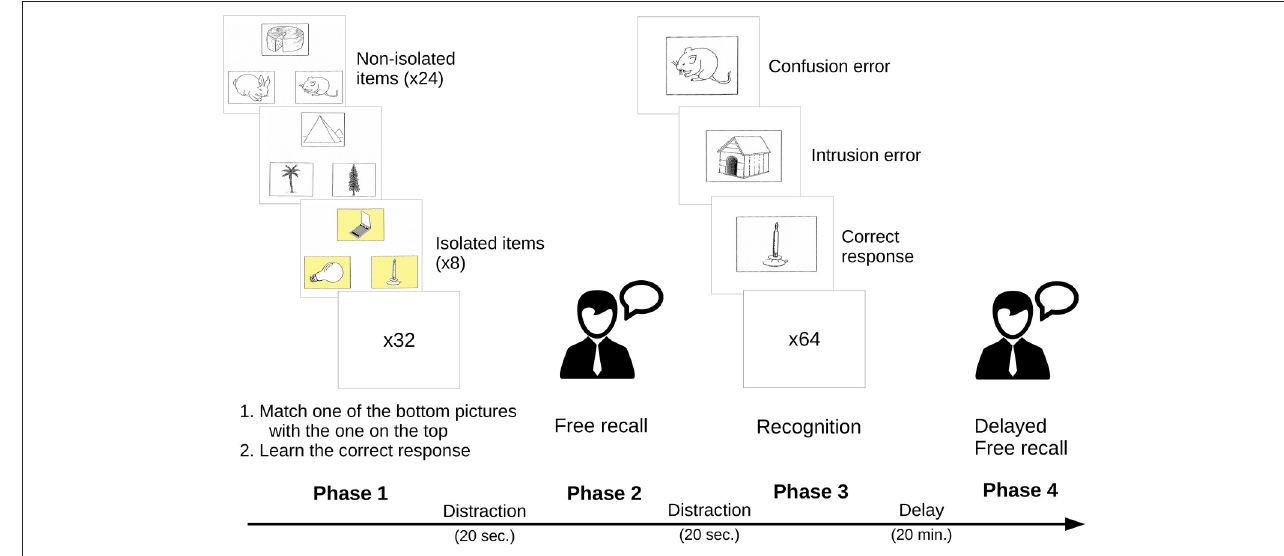
FIGURE 1 | Illustration of the general procedure and of the material used in the SEMEP.